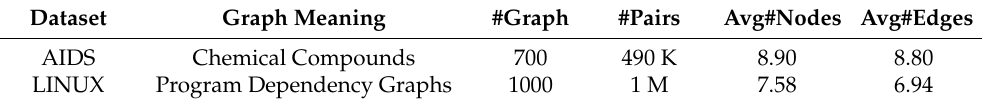
Table 1. Introduction to datasets.